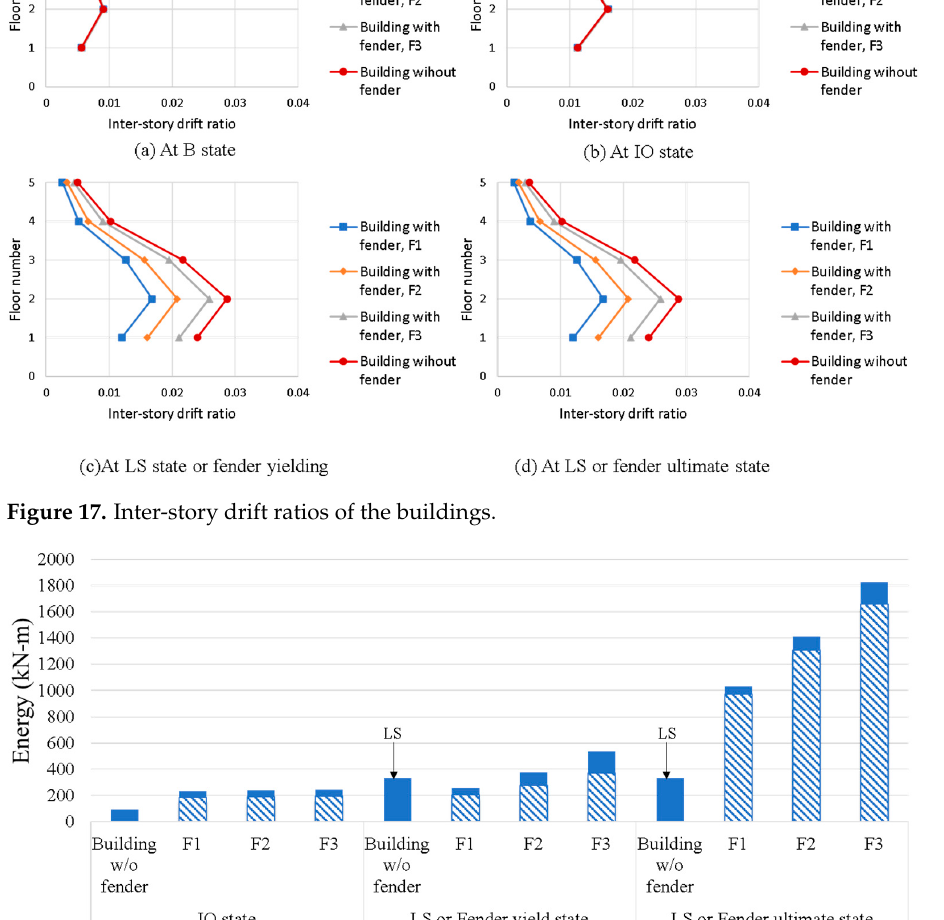
Figure 17. Inter-story drift ratios of the buildings.